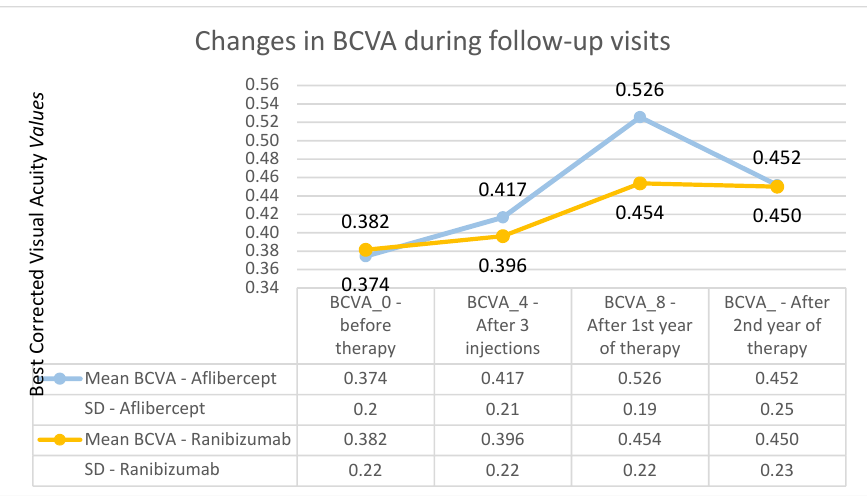
Figure 3. Changes in the best corrected visual acuity during individual follow-up visits—comparison of Aflibercept and Ranibizumab treatment results. The course of the best corrected visual acuity curve is much flatter for the group receiving Ranibizumab.